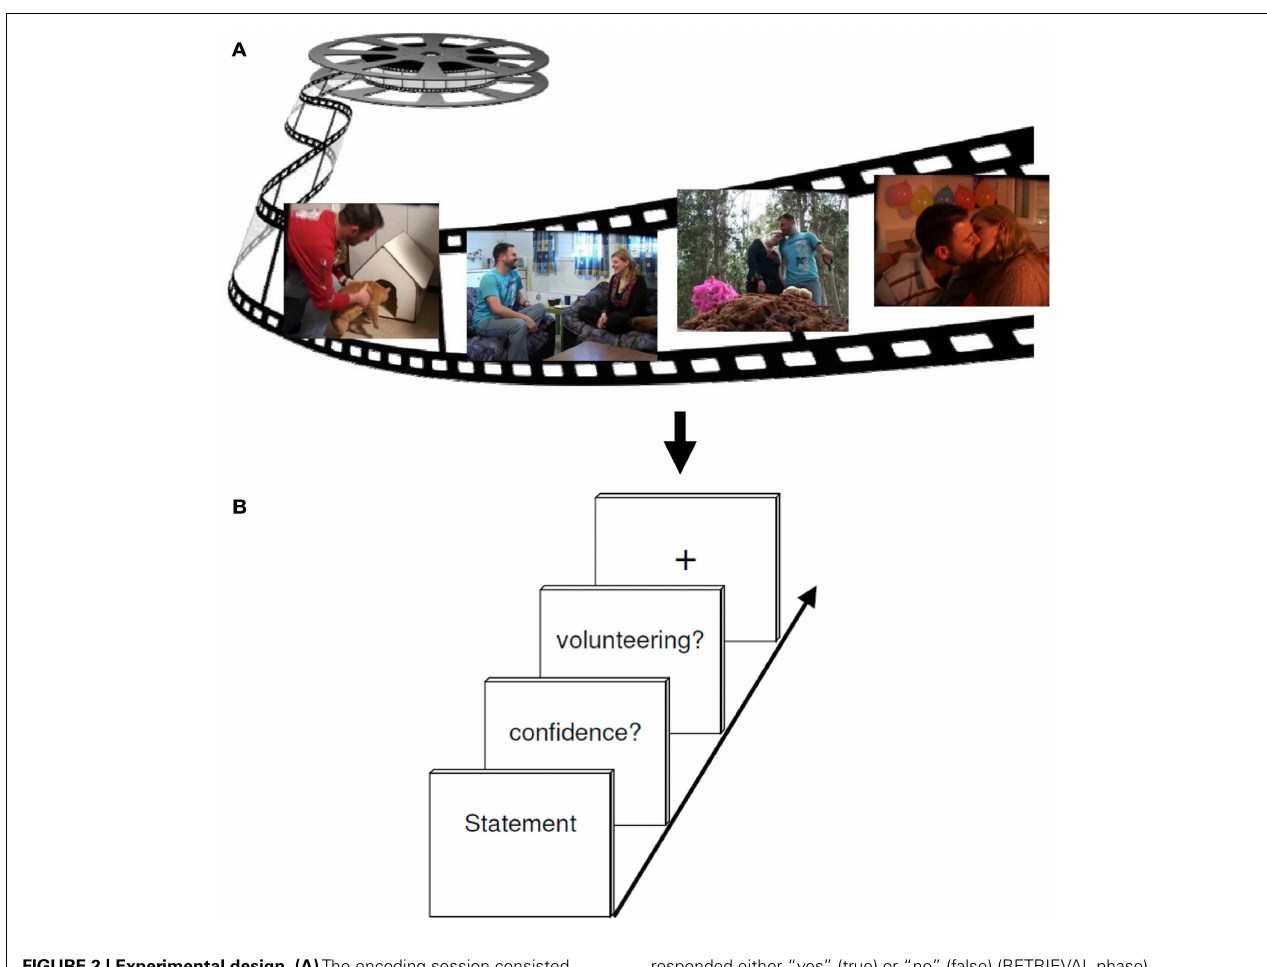
FIGURE 2 | Experimental design. (A) The encoding session consisted of watching a 6min emotional film in a quiet room. (B) About 2h later, participants performed a test session while undergoing an fMRI brain scan. Each retrieval task trial included either a correct or